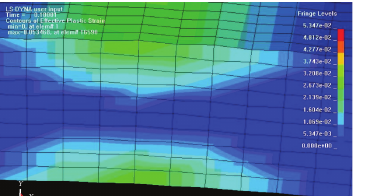
Figure 3: Finite element model.